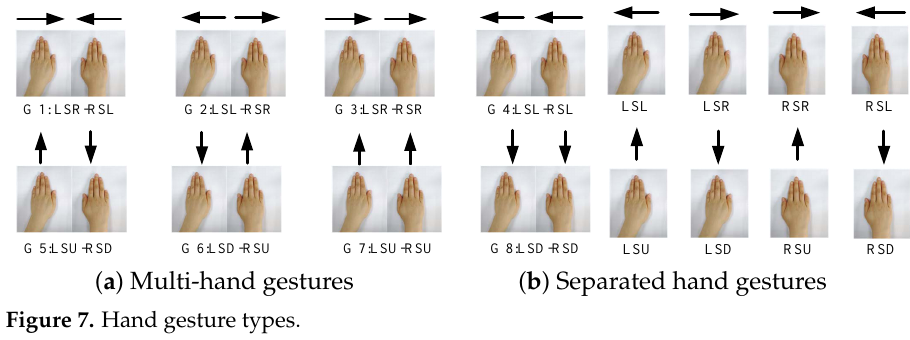
Figure 7. Hand gesture types.